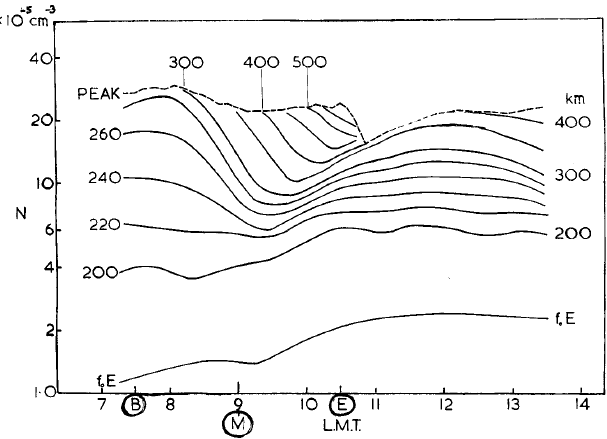
Fig. 4. Electron density N ( h,t ) and the F2 peak electron density, recorded at Singapore (1 (cid:176) N, 104 (cid:176) E) during the partial eclipse of 19 April 1958. Letters B , M , E mark the beginning, maximum and end of the eclipse. (Radio Research Station/Rutherford Appleton Labora-